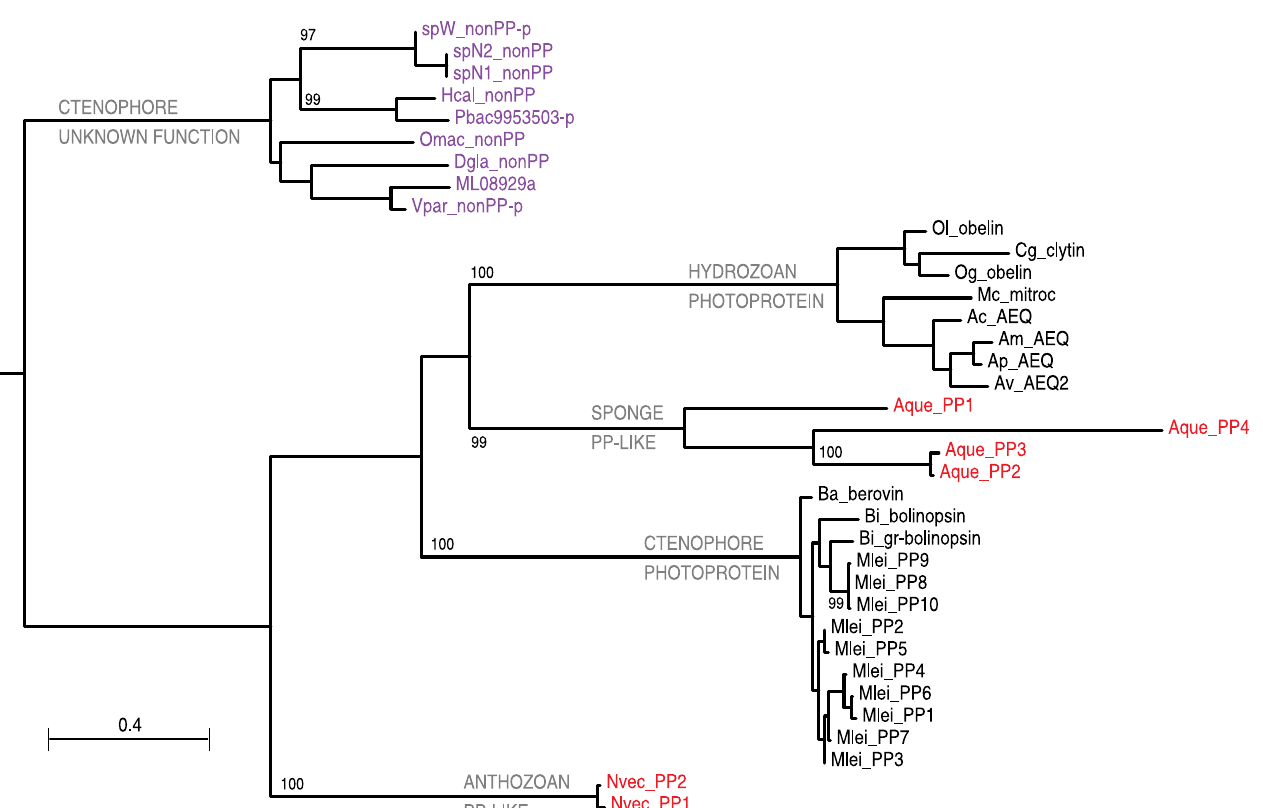
Fig 6. Maximum-likelihood tree of putative ctenophore photoprotein-like proteins. Maximum-likelihood tree of recovered ctenophore photoprotein-like genes and a set of verified cnidarian and ctenophore photoproteins from Schnitzler et al . (2012) [23]. Bootstrap values above 90 are shown. Abbreviations are as in Fig 5 with a few changes and additions: Ac, Aequorea coerulescens ; Aque, Amphimedon queenslandica ; Am, Aequorea macrodactyla ; Ap, Aequorea parva ; Av, Aequorea victoria ; Ba, Beroe abyssicola ; Bi, Bolinopsis infundibulum ; Cg, Clytia gregaria ; Mc, Mitrocoma cellularia ; Nvec, Nematostella vectensis ; Og, Obelia geniculata ; Ol, Obelia